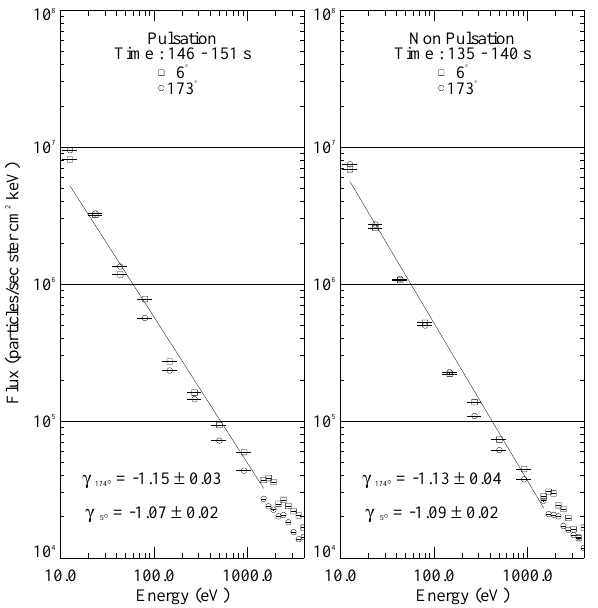
Fig. 7. Low energy (E < 1keV) spectra of the time intervals of 148– 151s (pulsation) and 135–140s (background). The electrons are from 6 ◦ and 174 ◦ pitch angles. Power law fits show that the up- and downgoing spectra are identical for both pulsation and background time intervals. Fig. 8. Pitch angle distributions for selected energies for 119s and 127s. Electrons with energies below 200eV are shown as well as electrons at 4keV. The low energy electrons show a slightly anisotropic distribution. The higher energy electrons begin to show a loss cone at near 50 ◦ pitch angle. The ratio of upward to down- ward pitch angle integrated electrons is shown in the bottom